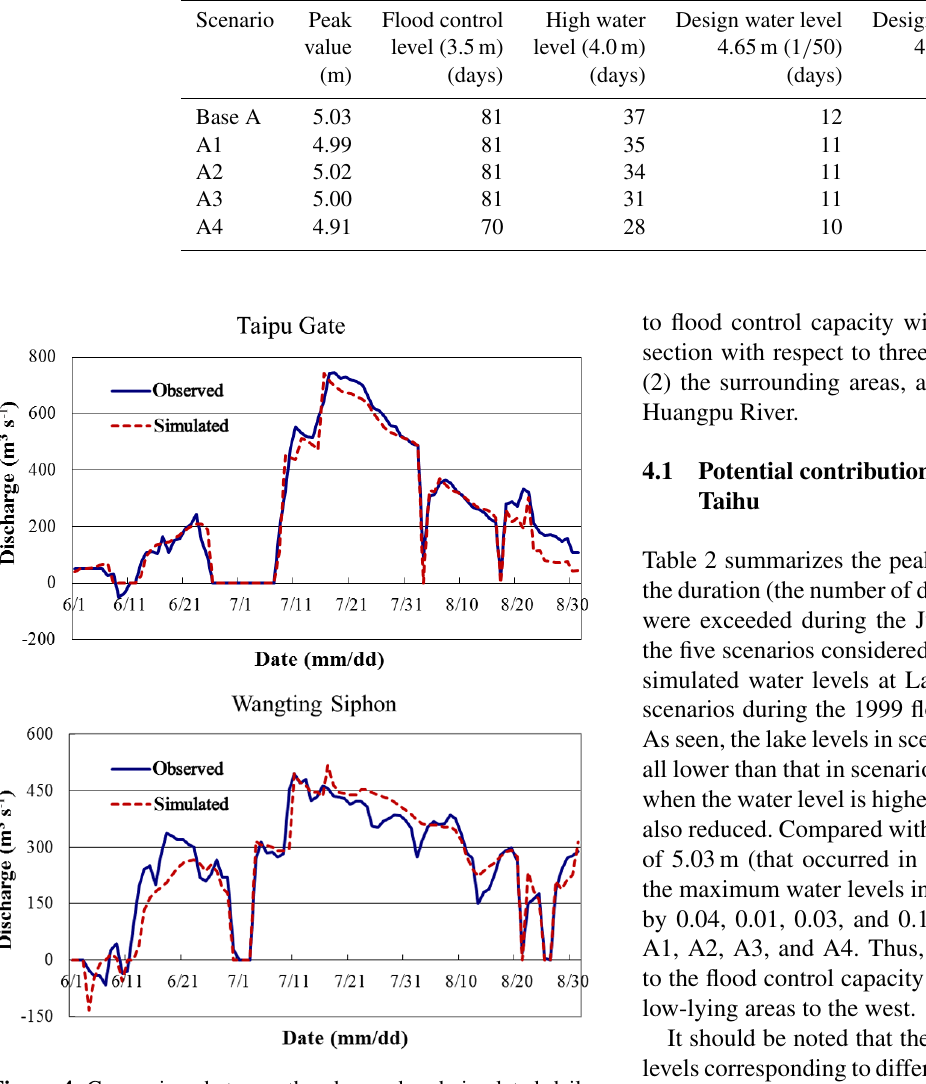
Figure 4. Comparison between the observed and simulated daily discharges from June to August in the 1999 flood event at the Taipu Gate station and the Wangting Siphon station (adapted from Ou and Wu,